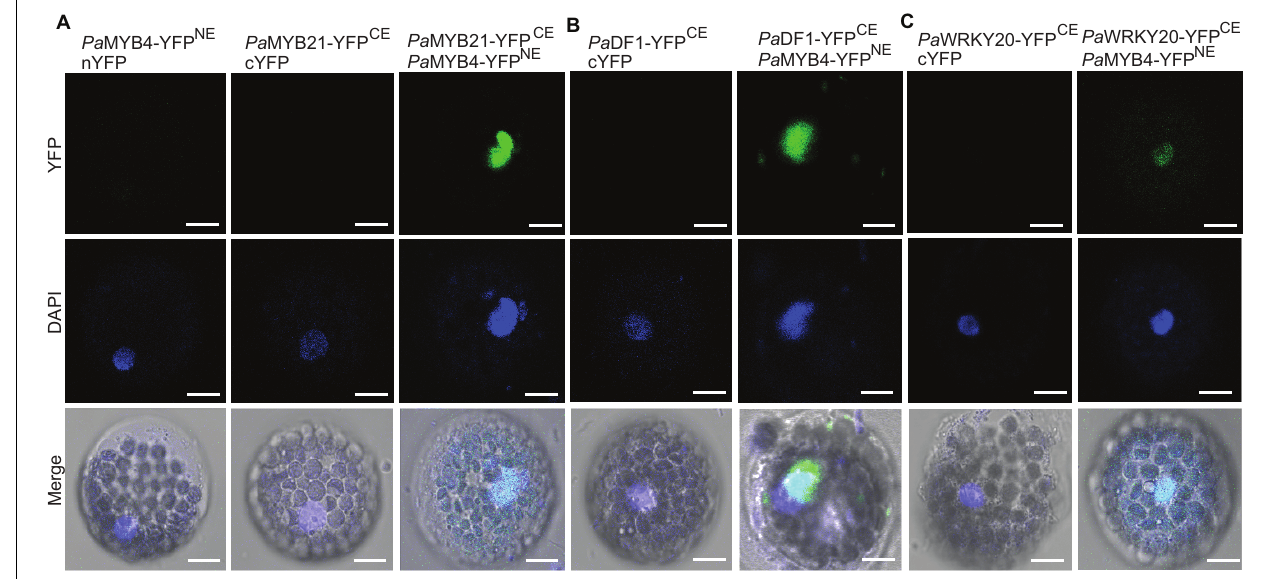
FIGURE 4 | BiFC validation of the in vivo interaction between Pa MYB21, Pa DF1, or Pa WRKY20 and Pa MYB4/LTF1. (A–C) Pa MYB21-, Pa DF1-, or Pa WRKY20-YFP CE and Pa MYB4-YFP NE interact to form a functional YFP in the nucleus of Arabidopsis leaf protoplasts. The DNA fluorochrome 4 (cid:48) , 6-diamidino-2-phenylindole (DAPI) was used to stain the cell nucleus (blue). Bar = 10 µ m.